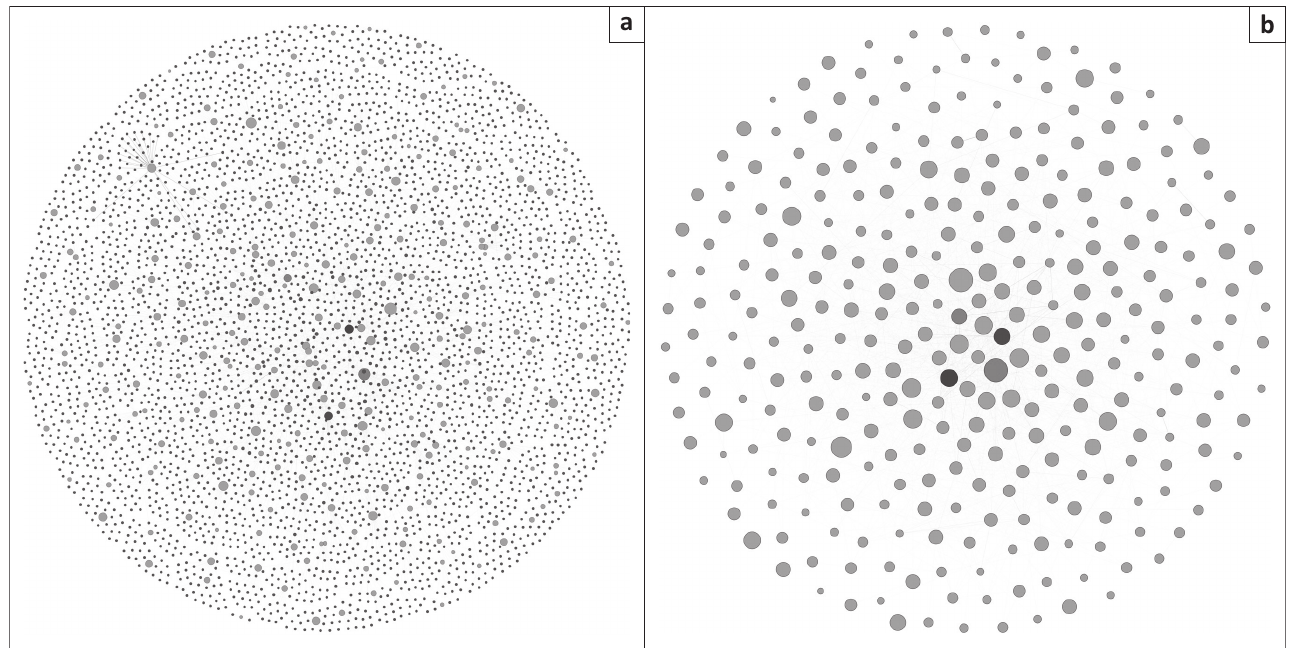
FIGURE 2: The four major South African banks in the company director network on the Johannesburg Stock Exchange, using the bipartite (a) and single-mode projections